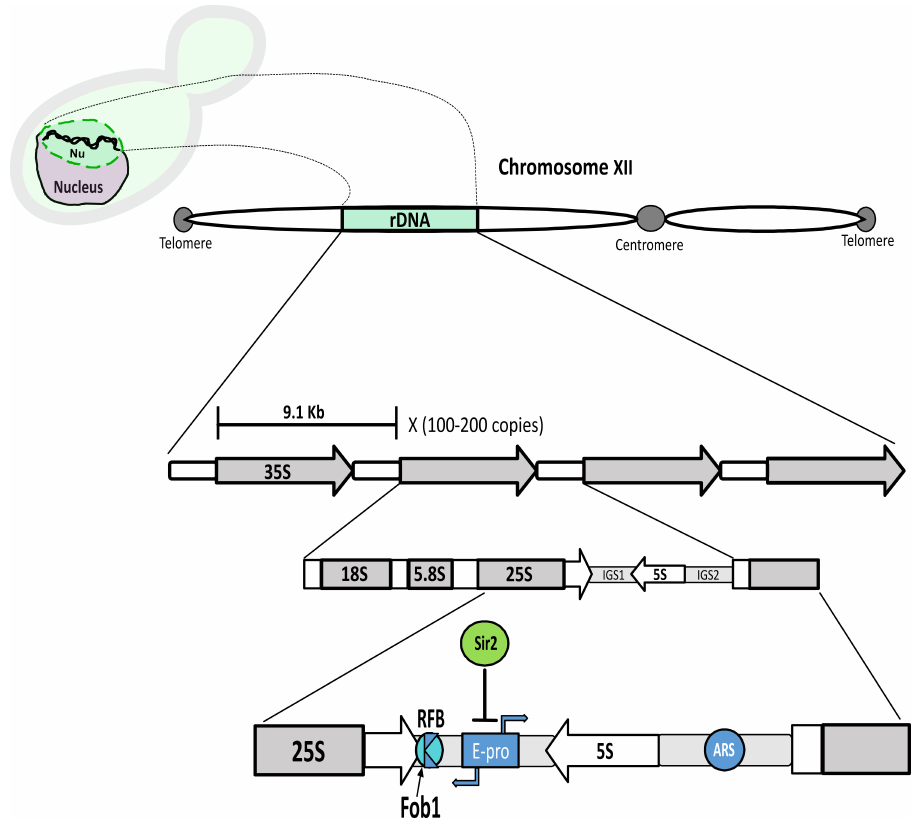
Figure 1. Schematic representation of the ribosomal DNA array; Top lef: A yeast cell with the rDNA portrayed as a two coiled chains (black) inside the nucleolus ( Nu ) (green), which occupies the upper part of the nucleus (light purple) in this drawing. Top middle: The rDNA (green) is located on the right arm (here left) of chormosome XII. Middle: Representation of the basic 9.1 Kb unit, repeated 100–200 times in tandem. The 35S transcription unit (transcribed by the RNApol I) is depicted (18S, 5.8S and 25S). These are separated by internal transcribed spacers (ITS1 and ITS2) (not shown), besides external transcribed spacers which lie at the 18S and 25S ends (not shown). The 35S and the 5S are separated by two intergenic regions (IGS1 and IGS2). Bottom middle: Specific features in the IGS1 and IGS2 regions. IGS1: E-pro, cryptic bidirectional promoter (RNApol II), silenced by Sir2; RFB, replication fork block. Binding of Fob1 at RFB, creates a unidirectional barrier for oncoming replication to avoid collision with ongoing transcription from the 35S. Direction of arrows represents direction of transcription; IGS2: ARS, origin of rDNA